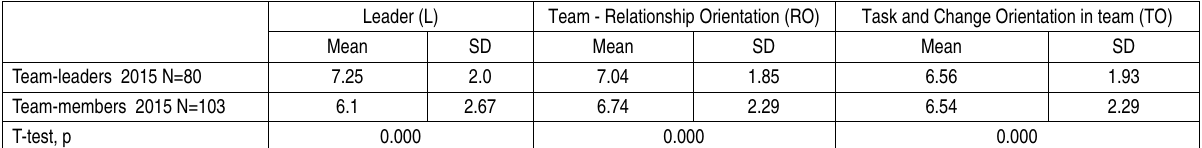
Table 5. The perception of team leaders and team members of elements of LIC (impact of leader trustworthiness and behavior, and relationship, task and change orientation) in Estonian organzations in 2015 Leader